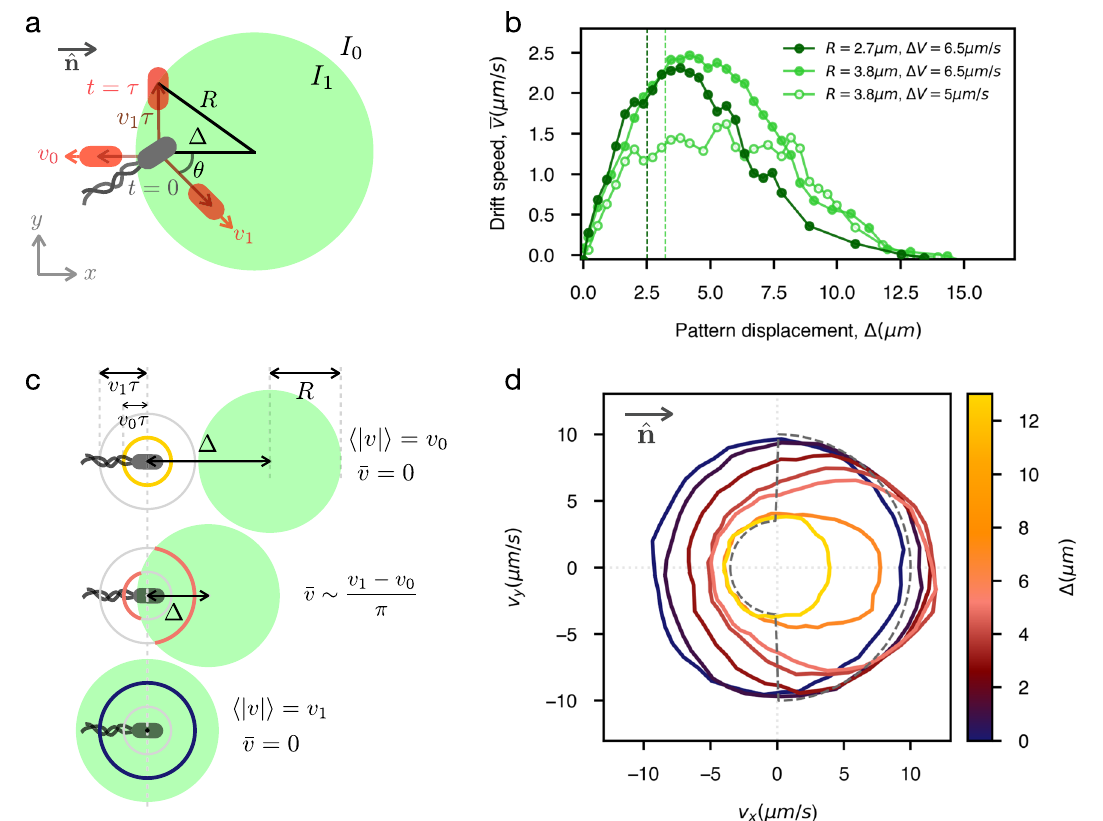
Fig. 2 Recti fi cation. a Schematics of an optimal choice for feedback parameters resulting in maximum recti fi cation towards the right. The white background corresponds to minimum light intensity I 0 with associated cell velocity modulus v 0 and the green areas to maximum light intensity I 1 and v 1 . A ffiffiffiffiffiffiffiffiffiffiffiffiffiffiffiffiffiffiffiffiffiffi q R 2 (cid:3) ð v τ Þ 2 (Eq. (3)) to the right of the cell's position at time t = 0. In red the different circular spotlight of radius R is shifted by a distance Δ ¼ Δ (cid:2) ¼ 1 possible positions at time t = τ are represented showing that all cells swimming at an angle ∣ θ ∣ < π /2 will move with maximum speed v 1 . b Drift speed of bacteria versus the displacement Δ for different radii R and velocities v 1 , v 0 . In all cases τ = R /2 v 1 . The dashed lines are the corresponding theoretical optima according to Eq. (3). c Evolution of the polar speed plot as a function of Δ . When Δ > R + v 1 τ cells will always be outside of their spotlight and swim with an isotropic speed v 0 (yellow). For Δ < R − v 0 τ cells will always be inside and swim with isotropic speed v 1 (blue). For intermediate values of Δ cells will have an angle dependent speed (red) swimming faster when moving towards right. d Polar speed plot for different values of Δ when ^ n ¼ ^ x , R = 2.7 μ m, τ = 0.1 s,